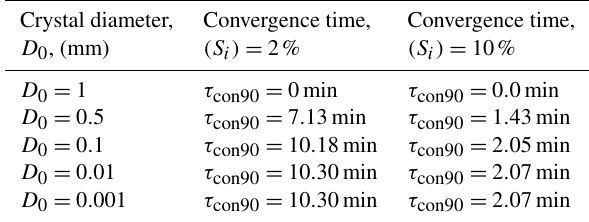
Table A1. The time for nucleated ice crystals to converge to within 90% of an ice crystal growing in the same environment but with an initial nucleated size of 1mm, τ con90 , for two supersaturation levels.